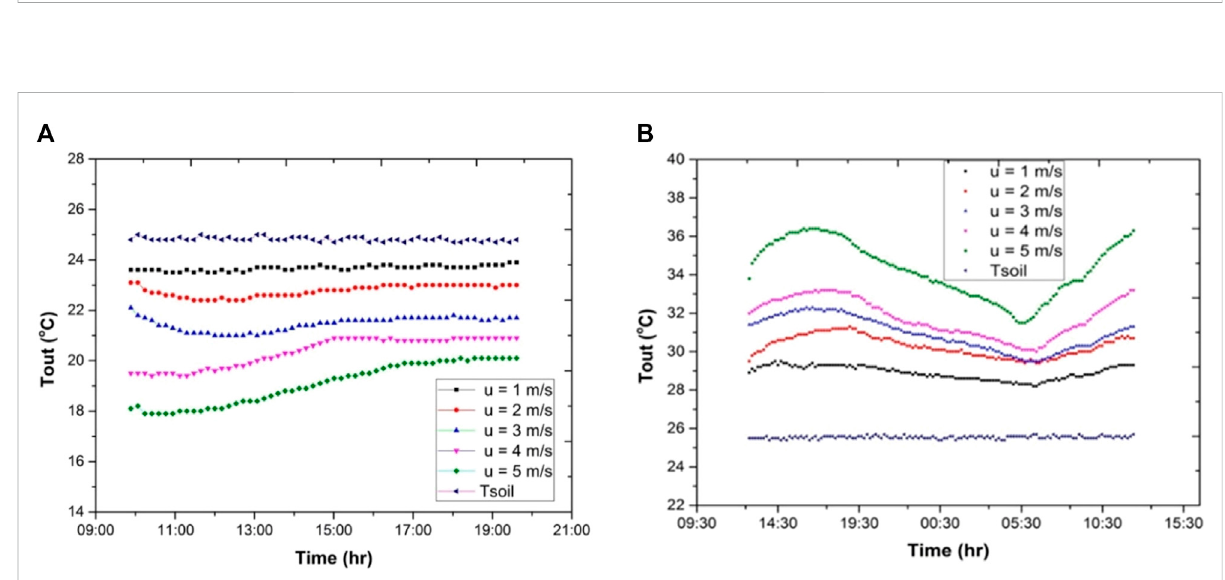
FIGURE 8 Variation of outlet temperature with air velocity during (A) January and (B)